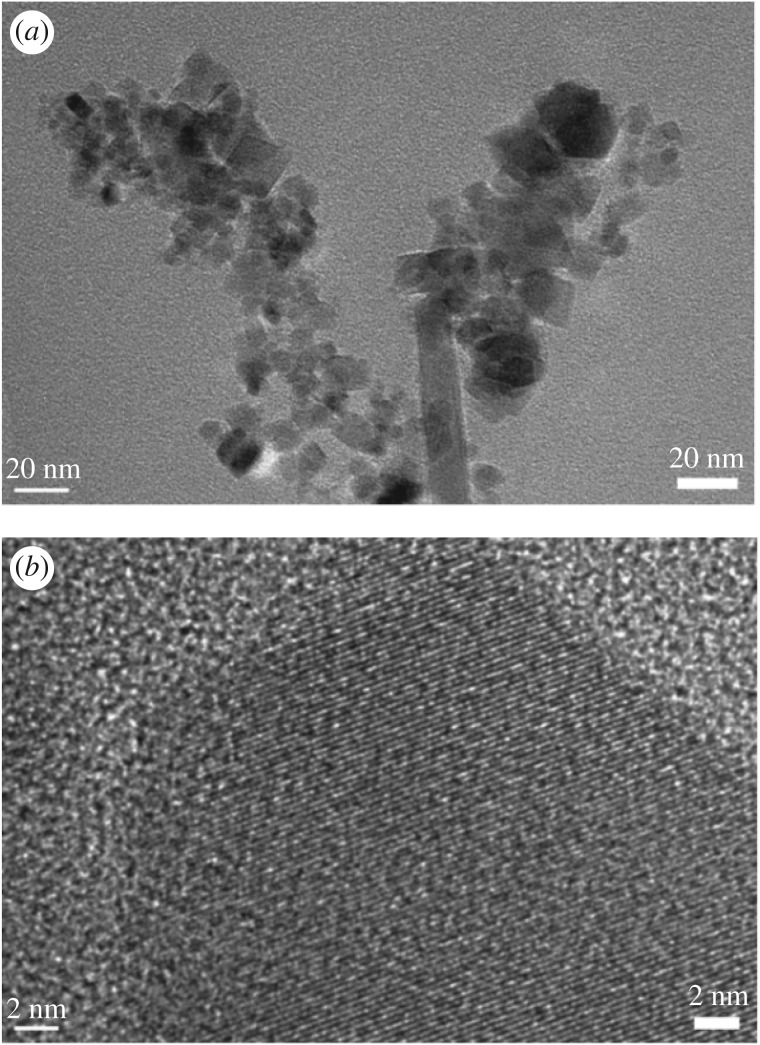
TEM images of Fe3O4 materials.